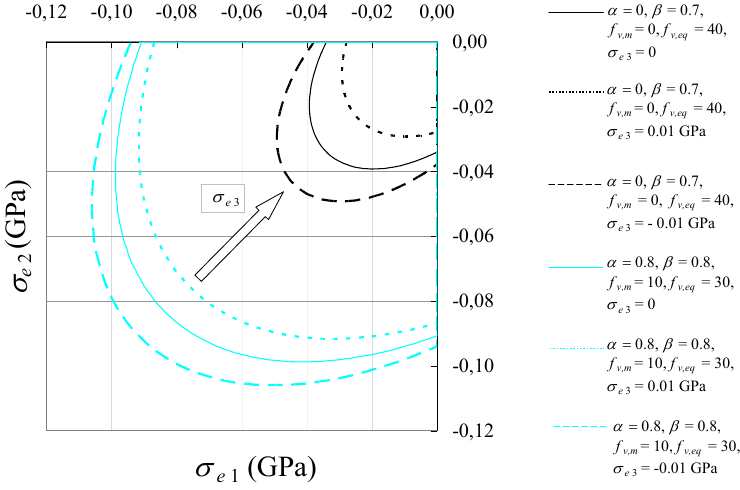
Figure 5: Failure curves in bi-axial and tri-axial